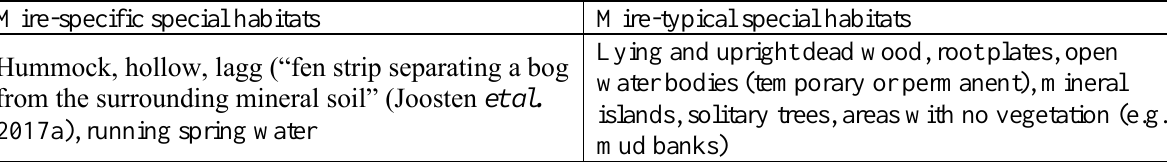
Table 4. Mire-specific and mire-typical special habitats occurring in the federal state of Brandenburg (north- east